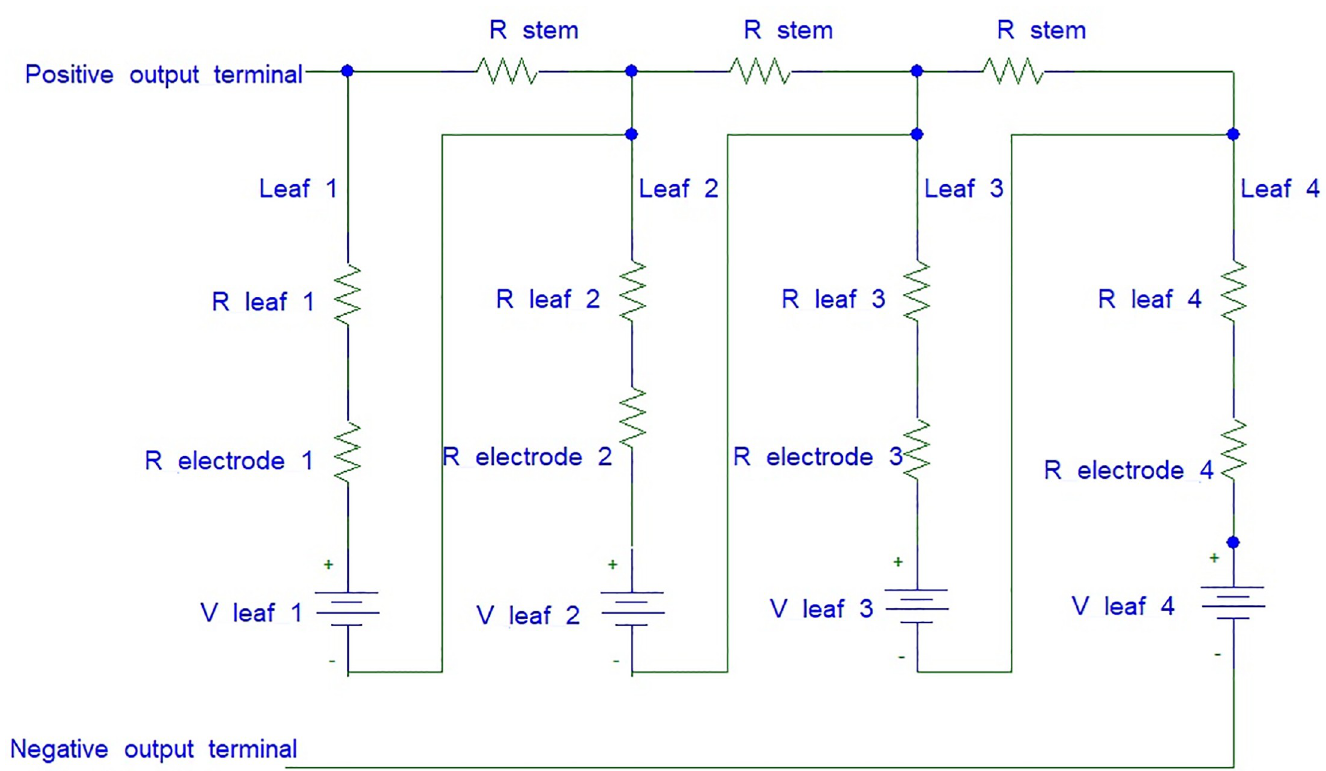
Fig 10. The equivalent circuit for series connection between leaves which by-pass the stem of the Aloe Vera.